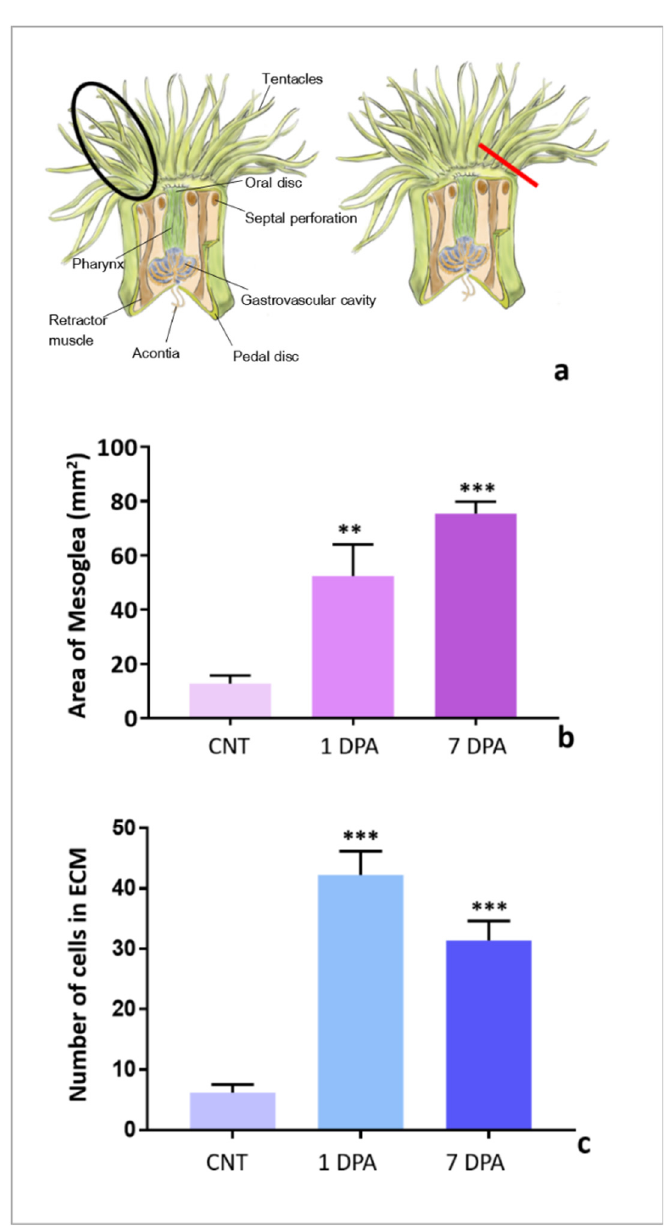
Figure 5. Comparison of ECM area and cell number between unamputated (black encircled) and amputated (red line) regenerating tentacles ( a ). The graphs show the quantification of the mesoglea area ( b ) and of elongated amoebocytes number ( c ) in noninjured (Cnt) and regenerating tentacles at 1 and 7 days post-amputation (dpa). Significant differences were detected by Fisher post hoc test—** p < 0.01 , and *** p < 0.001.